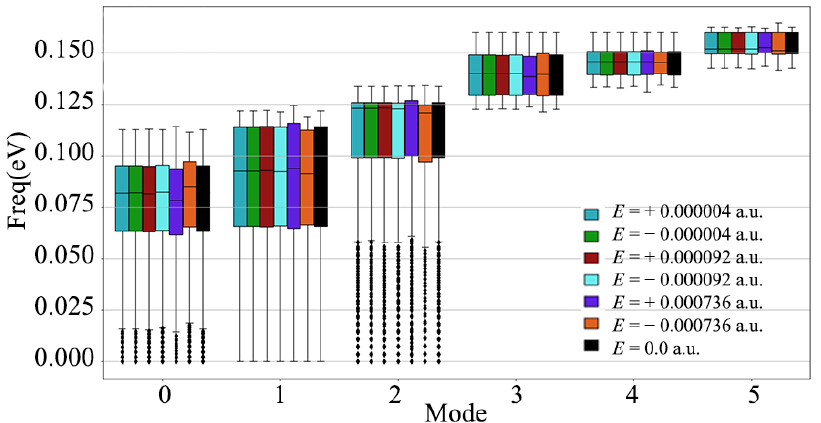
Figure 5. Frequency box plots of three acoustic branches and three optical branches of diamond after applying different electric field intensities along the [110] crystallographic direction.